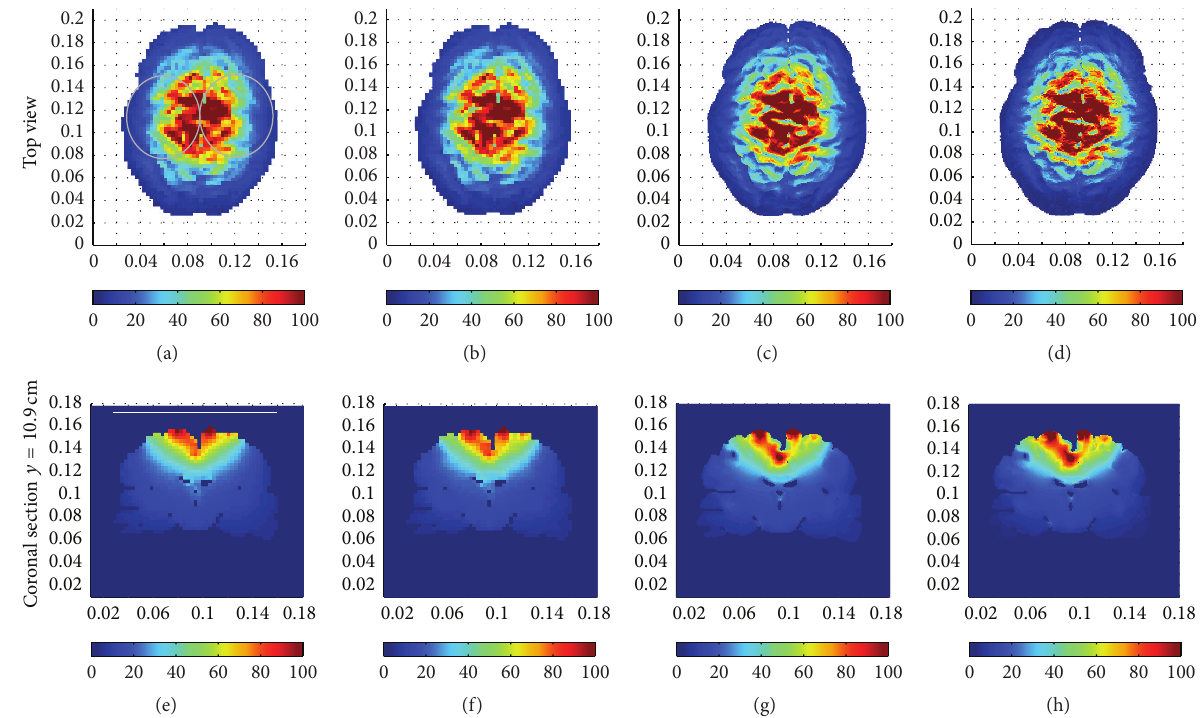
⃗𝐸| Figure 4: | (V/m) distributions induced in different brain models and/or different methods by MAG-9925-00 coil fed by a sinusoidal current 3 kHz, 3 kA. Distributions on the top surface (upper row) and on a coronal section at 𝑦 = 10.9 cm (lower row), respectively, for the homogeneous brain model with 3mm resolution (a) and (e), for the inhomogeneous brain model with 3mm resolution (b) and (f), and for the inhomogeneous brain model with 1mm resolution (c) and (g), calculated with the commercial code SIM4LIFE for the inhomogeneous brain model with 1 mm resolution (d) and